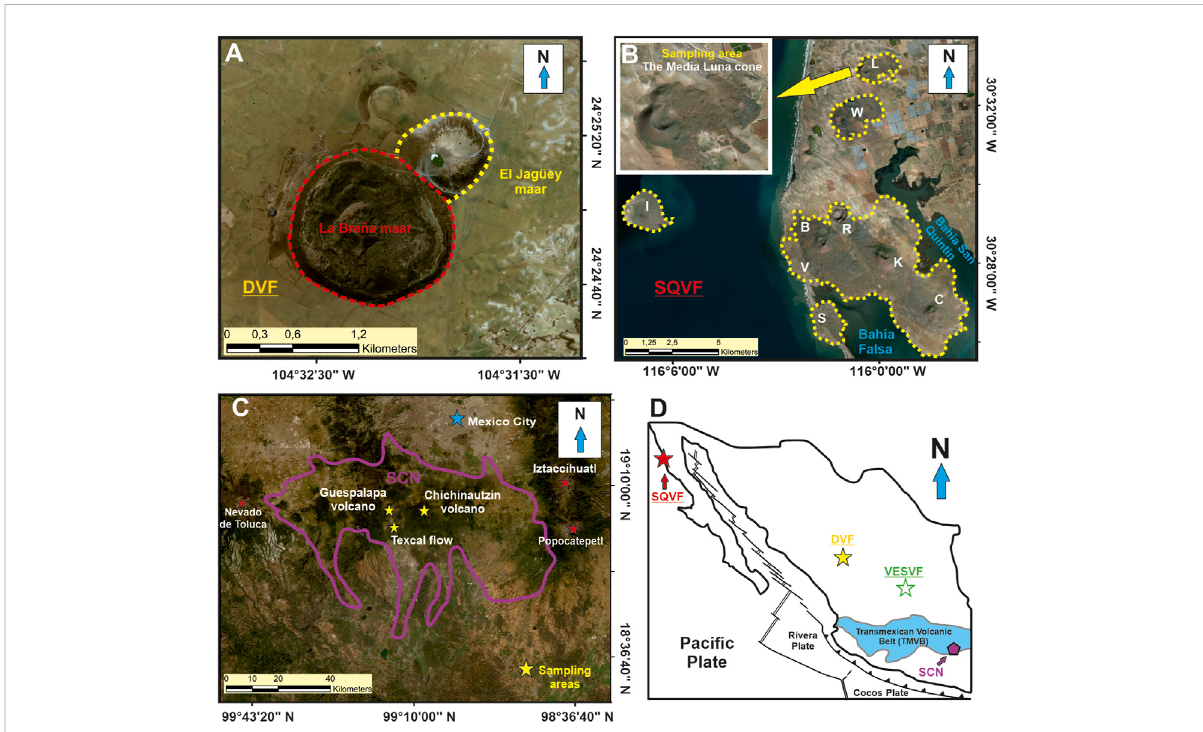
FIGURE 2 (A) Image from Google Earth (23 June 2021) showing La Breña-El Jagüey maar complex. (B) Image from Google Earth (23 June 2021) showing the San Quintin Volcanic Field (SQVF) and sampling area. Media Luna (L), Woodford (W), Basu (B), Riveroll (R), Kenton (K), Picacho Vizcaíno (P), Sudoeste (S), Ceniza (C), Monte Mazo (M) and Isla San Martin (I). (C) Image from Google Earth (23 June 2021) showing the Sierra Chichinautzin (SCN) and sampling areas. (D) Mexico overview map including the SQVF, DVF, VESVF, and SCN